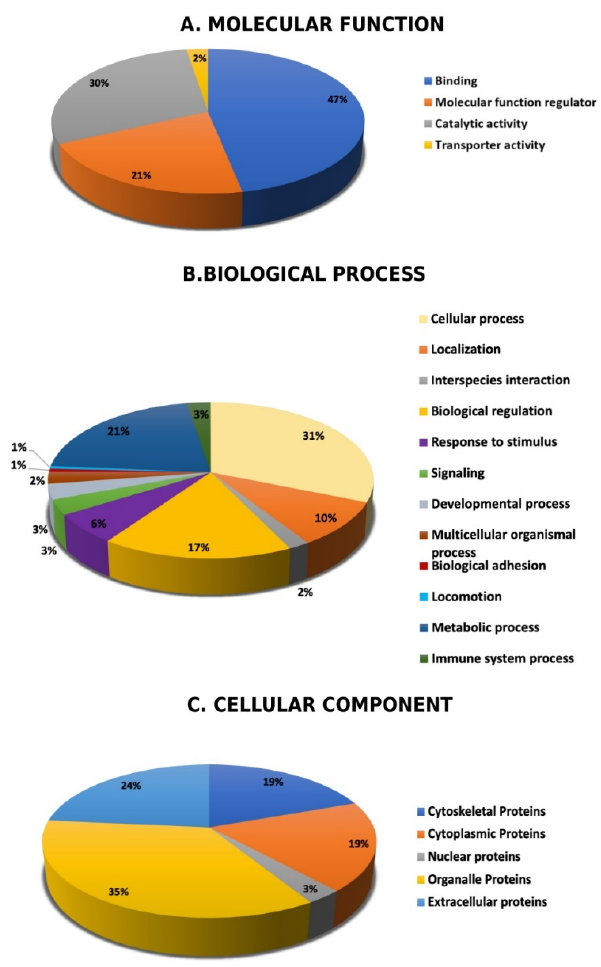
Figure 6. Comparative analysis (%) of identified proteins of interest classified into different groups according to their molecular function ( A ), biological process ( B ), and cellular components ( C ).